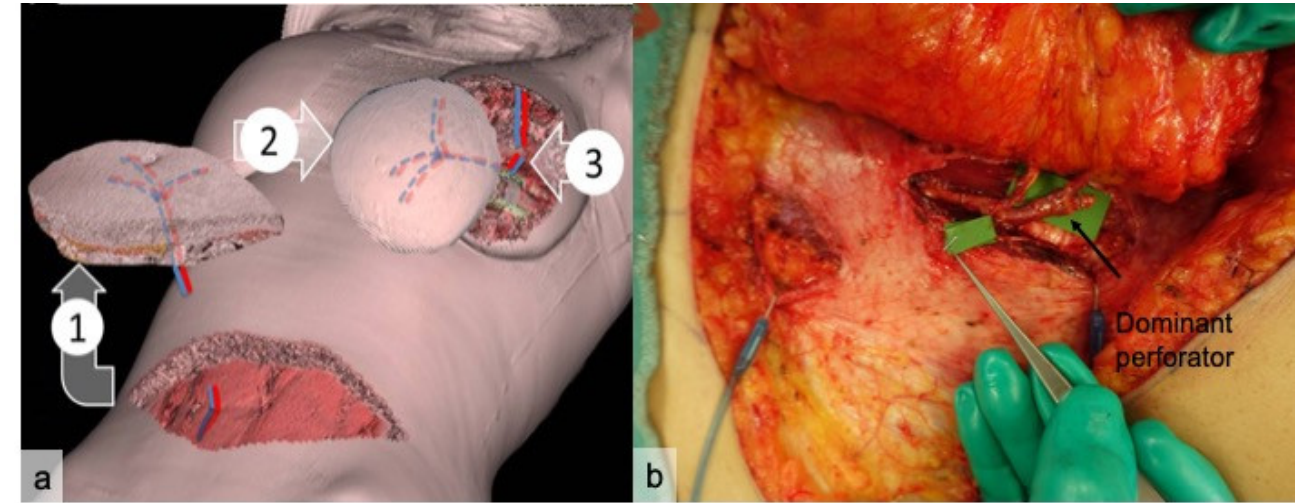
Figure 1. Three-dimensional graphic illustration of a DIEP (deep inferior epigastric perforator) flap procedure ( a ). In 1,